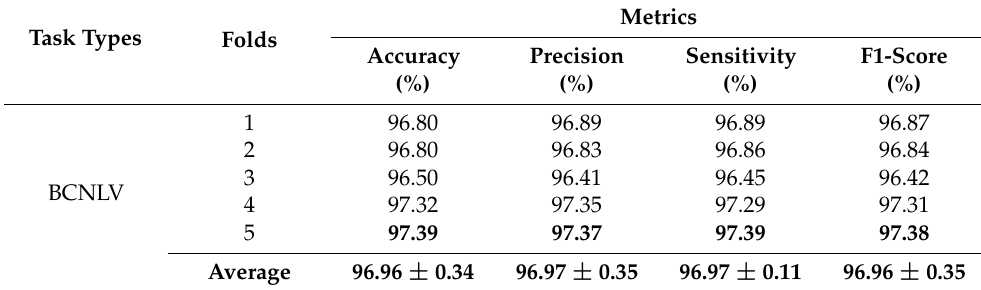
Table 5. Performance of FirecovNet on each fold in the 5-class classification tasks.